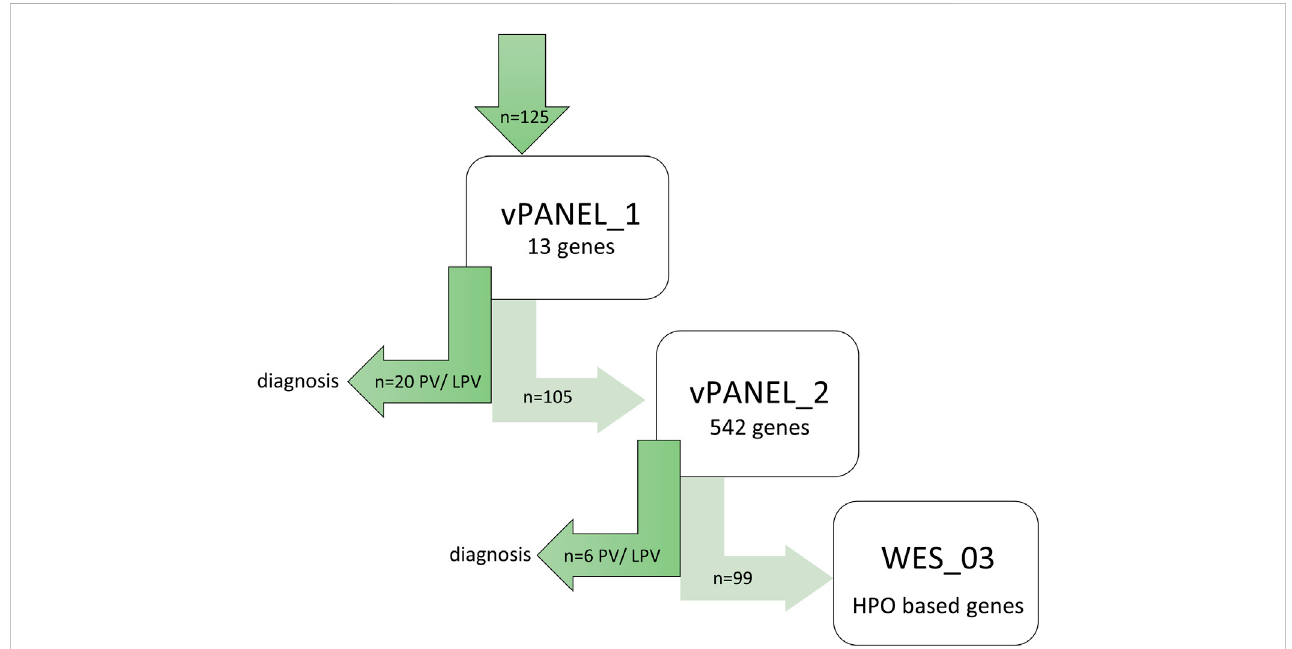
FIGURE 1 Genetic work fl ow displaying step-by-step diagnostic strategy. First, WES data from all patients were screened using virtual vPANEL_1 (13 genes); in case of non-con fi rmatory fi ndings, virtual vPANEL_2was analyzed (542 genes). In athird step, WES data (WES_3) were fi lteredto detect the most likelydeleterious variants highly suspicious for AID. Additionally, HPO terms were used according to the patient ’ s phenotype. If applicable, trio WES were performed; PV = pathogenic, or LPV = likely pathogenic variant found through genetic diagnostics.